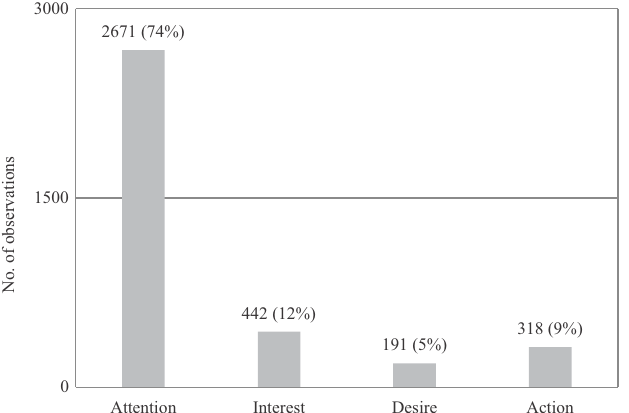
Fig. 3. Classification of comments, taking into account the criteria of the AIDA model Source : Own